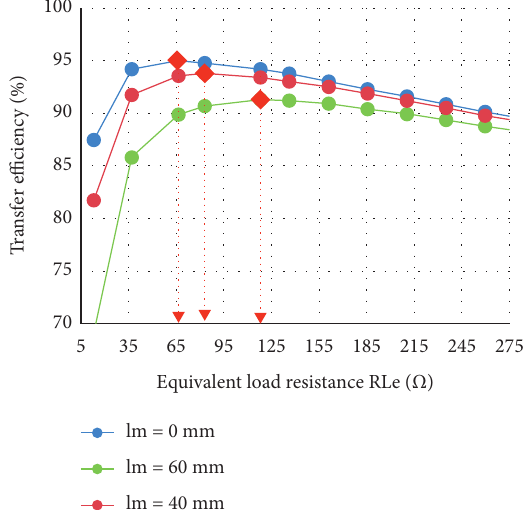
Figure 11: Transfer efficiency characteristic according to receiver position and equivalent impedance ( R L ). Figure 12: The transfer efficiency characteristics.